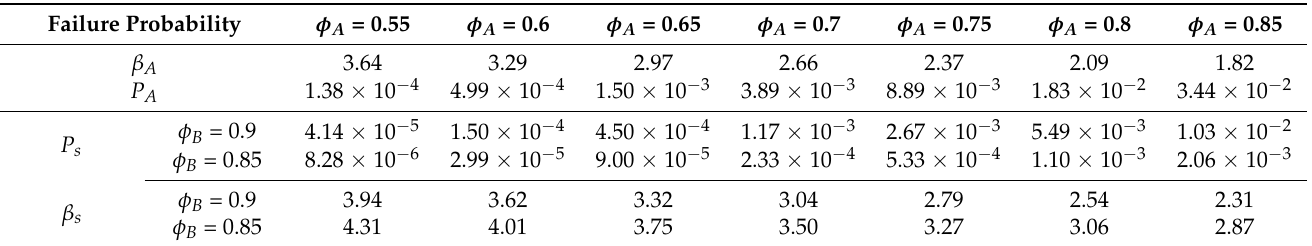
Figure 19. The average reliability index with different reduction factors. Table 6. Reliability and failure probability of CY beam under different reduction factors.